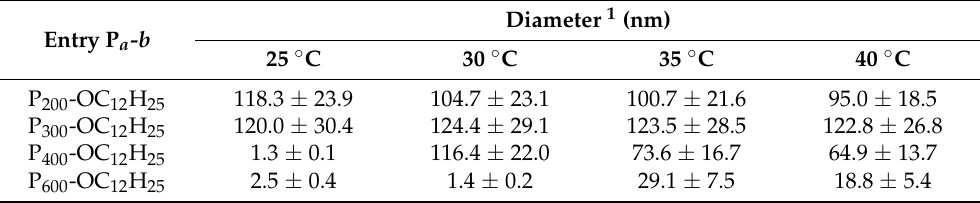
Table 6. Dependence of micelle diameter on the temperature and PEG’s chain length.